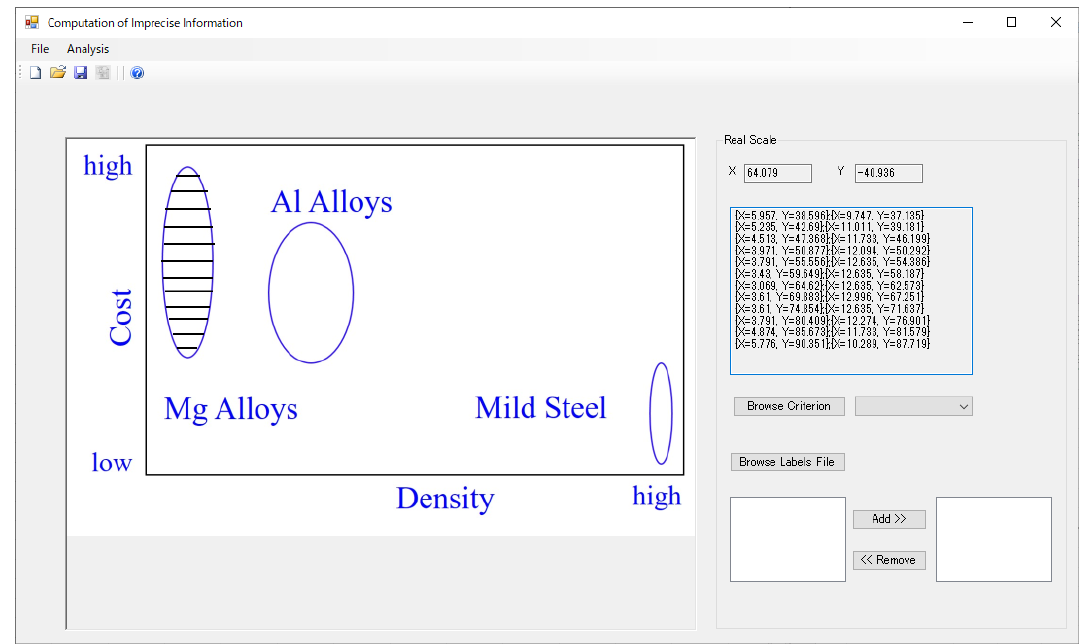
Figure 10. Extracting decision-relevant information from the plot of strength versus Yang’s modu- lus.